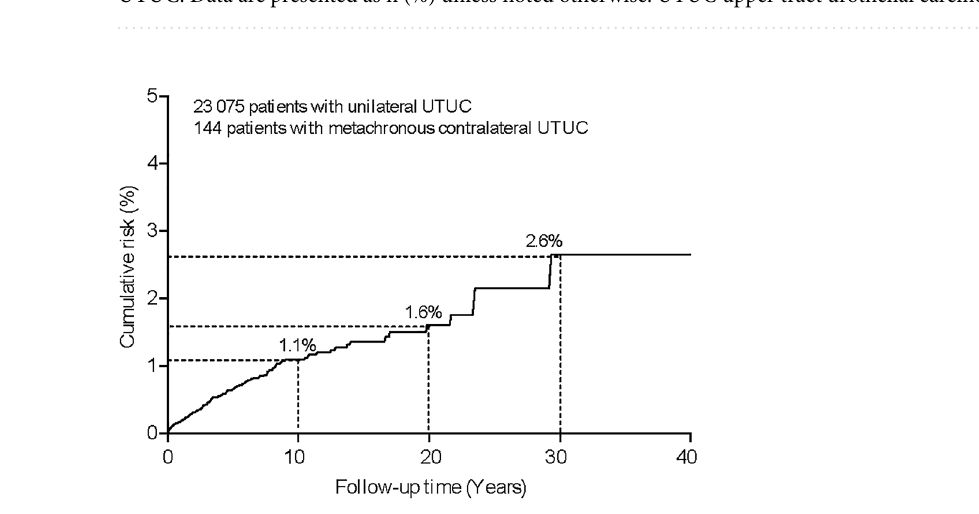
Figure. 1. Cumulative incidence of metachronous contralateral upper tract urothelial carcinomas